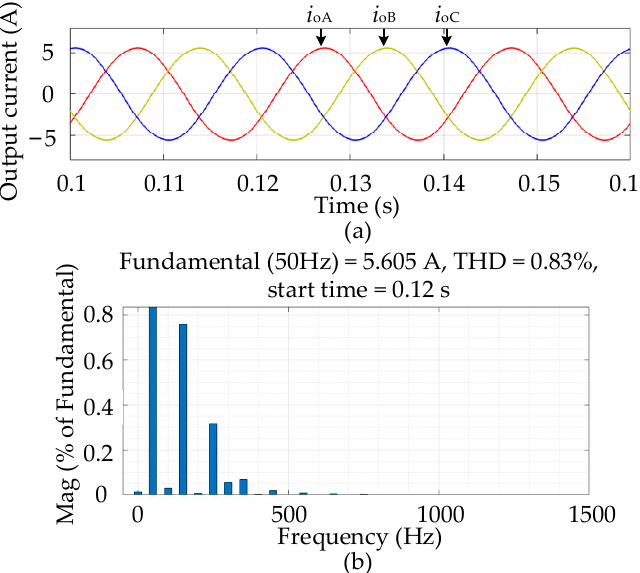
Figure 9. ( a ) The output current of each phase under the resistive–inductive load condition. ( b ) The FFT result of the A-phase output current.